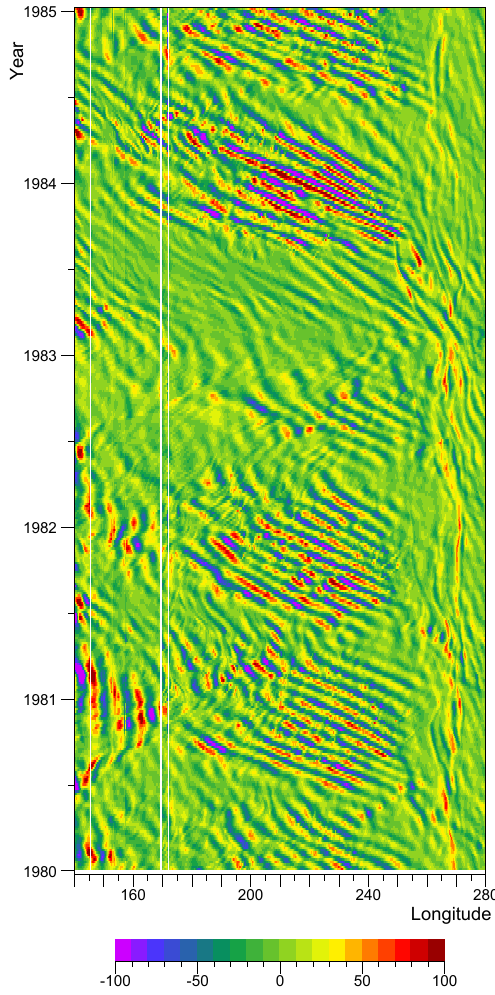
Figure 11. Pressure integral (10 6 Pam) defined in Eq. (4) at 6 ◦ N (after subtracting a constant equal to the same integral but with a constant density of 1024kgm − 3 and zero surface elevation). Verti- cal lines are due to shallow topography.